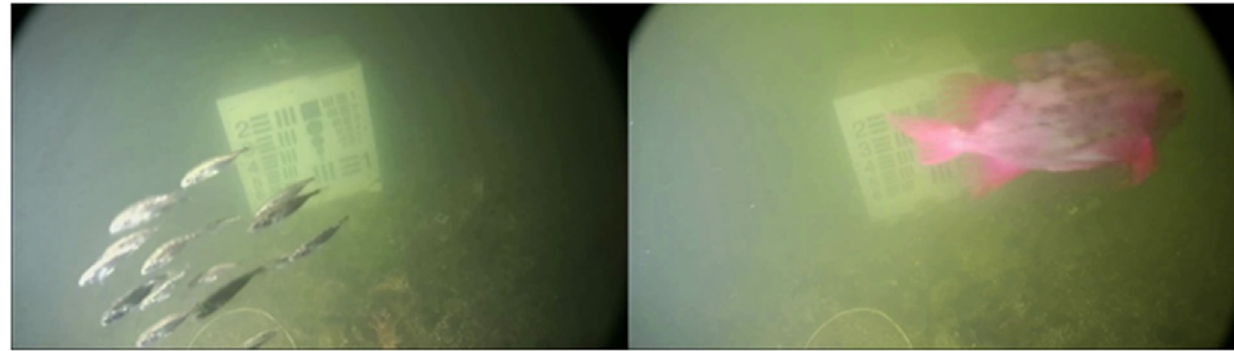
Figure 11. Visualization detection results for the URPC 2020 underwater dataset compared with YOLO v4 and Tiny YOLO